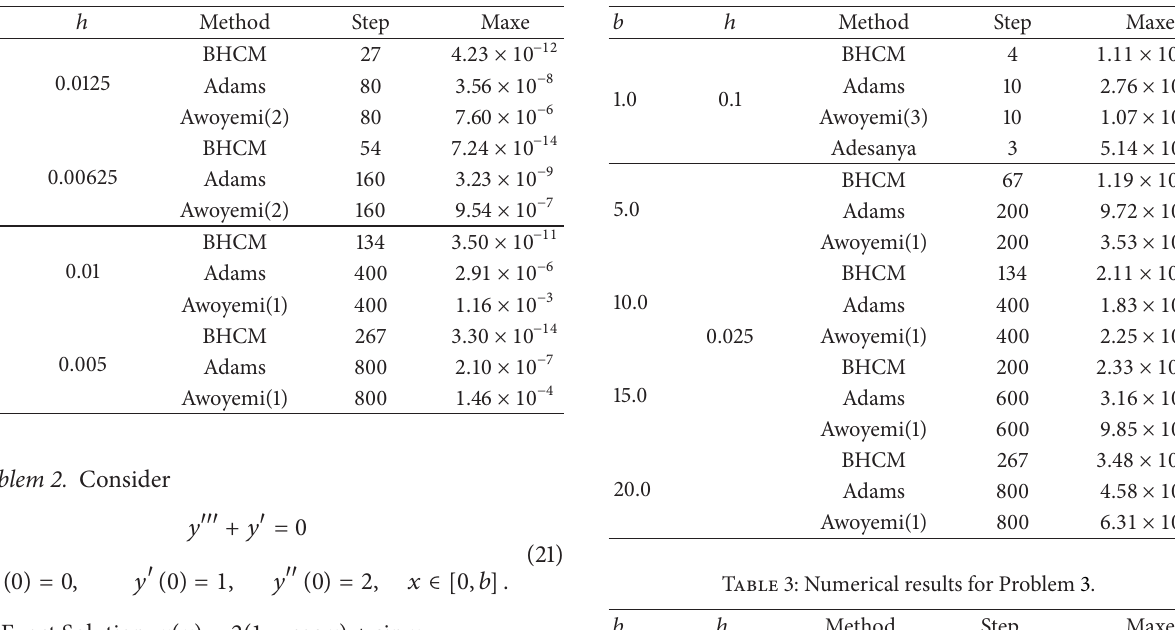
Table 1: Numerical results for Problem 1. Table 2: Numerical results for Problem 2.